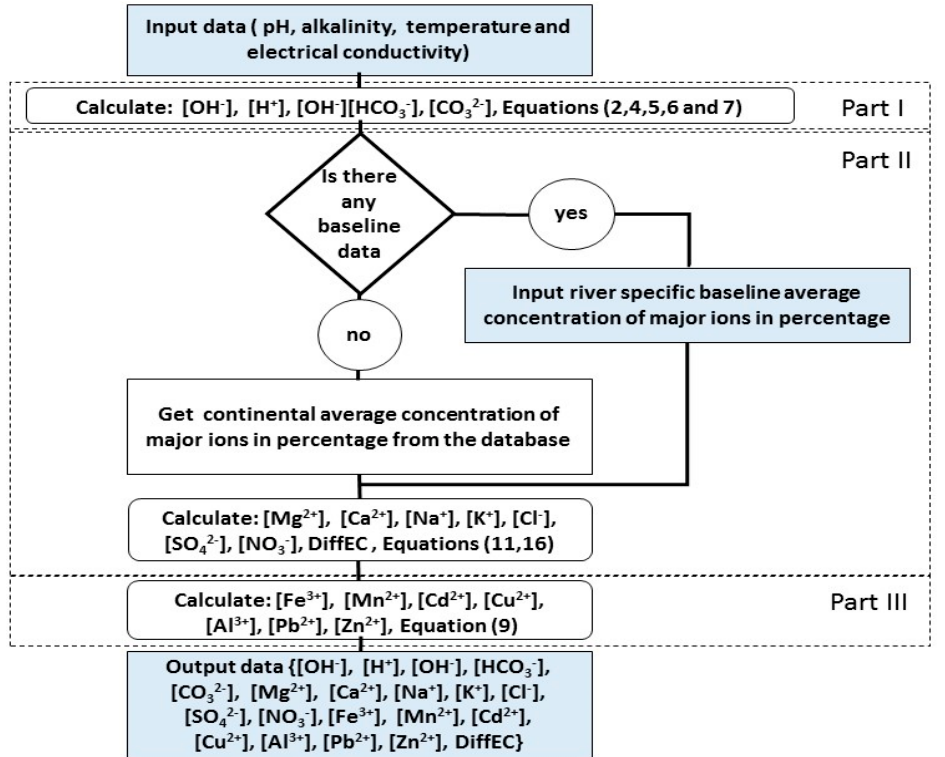
Figure 3 . Overview of the model algorithm. Figure 3. Overview of the model